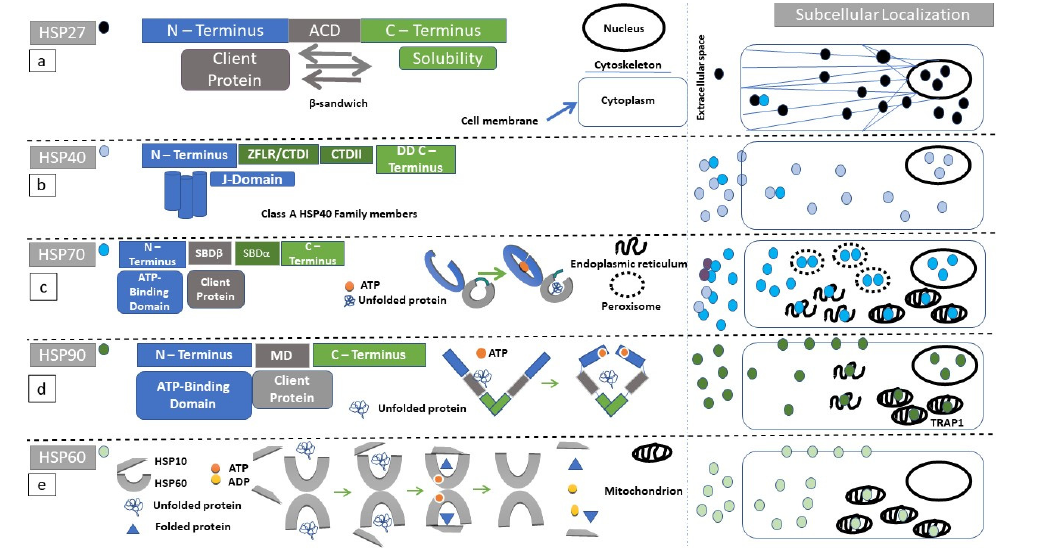
Figure 1. Structure and function of heat shock proteins (HSPs): Diagrammatic representation of the domain structure and subcellular localization of HSPs under discussion. Of note is the fact that heat-shock proteins can form complexes with other molecular chaperones. These chaperone complexes may exert a different action than the uncomplexed HSPs. ( a ) HSP27 (black circle) secondary structure, consists of an N-terminal (blue rectangle) substrate-binding region, followed by an alpha crystallin domain (ACD, gray rectangle) ending in the C-terminus (green rectangle). ACD has a β -sandwich conformation. Client proteins dock to ACD. The C-terminus is highly variable among protein members and facilitates HSP27 oligomerization. ( b ) Class A HSP40 (blue circle) protein family secondary structure consists of an N-terminal (blue rectangle) substrate-binding region, followed by a zinc finger-like region (ZFLR), C-terminal domains I and II (CTDI and II, green rectangles in c-terminal region), and ending in a dimerization domain (DD). The J-domain localizes within N-terminal region. Class B preserves the N-terminal localization of the J-domain but the C-terminus can acquire a more diverse structure. In class C, the J-domain can be localized anywhere within the amino-acid sequence. ( c ) HSP70 (turquoise circle) secondary structure consists of an N-terminal domain (blue rectangle), followed by a substrate-binding domain (SBD β , gray rectangle), a substrate-binding domain α -helical (SBD α , gray rectangle), and ending in the C-terminus (green rectangle). The reaction cycle involves ATP docking within N-terminal domain since ATP hydrolysis powers the structural opening of the substrate cleft within the SBD β (gray arc). ( d ) The HSP90 (dark green circle) secondary structure consists of an N-terminus (blue rectangle), followed by a middle domain (MD, gray rectangle), ending in a c-terminus (green rectangle). HSP90 homodimerizes with the use of its c-terminal region. Unfolded proteins are docking in the MD. ATP hydrolysis is required for substrate processing. ( e ) The HSP60 (light green circle) reaction cycle. Unfolded substrates enter the HSP60 processing cleft. HSP10 acts as a lid, and ATP-hydrolysis is necessary for substrate folding. Each one of the sHSPs plays a pivotal role in stabilizing denatured native